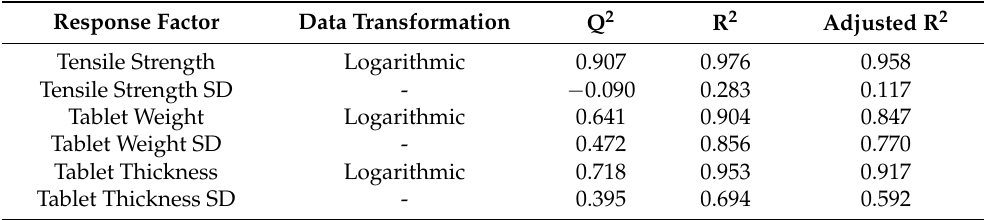
Table 9. Overview of fit statistics regarding tablet